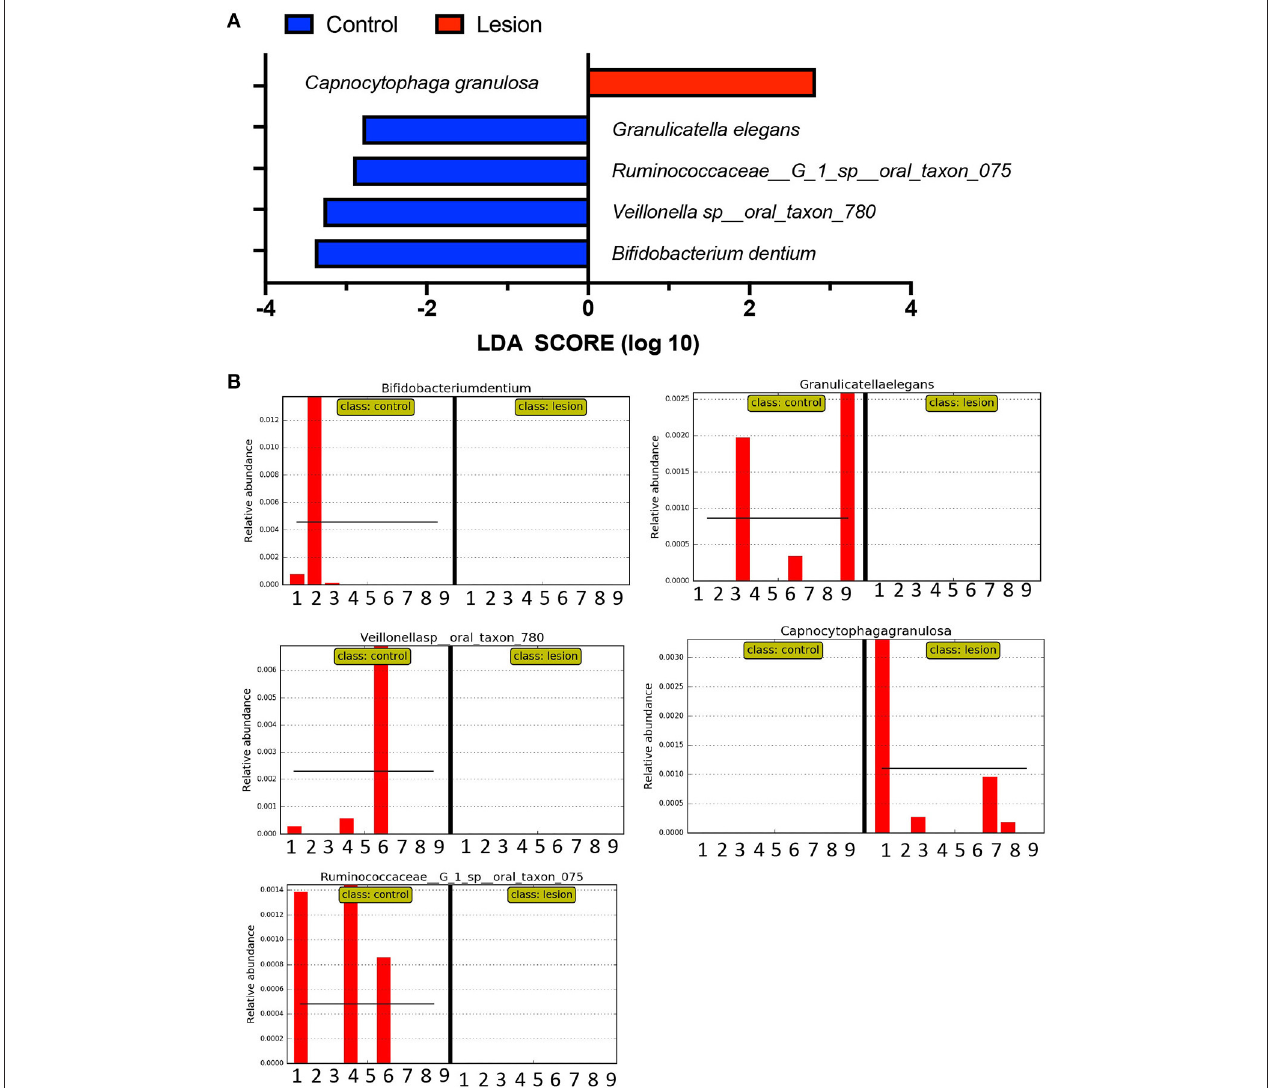
FIGURE 3 | Linear discriminant analysis of microbiome data. Using LefSe, we queried our 18 microbiome samples to identify OTUs most likely to define the oral lesion condition, using an LDA cutoff of two orders of magnitude. (A) Collectively, one bacterial species was identified as enriched in oral lesion subjects, C. granulosa , shown in red. Four bacterial species were elevated in controls compared to oral lesion patients and are shown in blue. (B) The distribution of potential biomarkers by subject. For each chart, the first nine columns represent controls, while the second nine columns represent oral lesion subjects. At least one of the four control markers is found in six of nine subjects, and the oral lesion marker is found in four of the nine